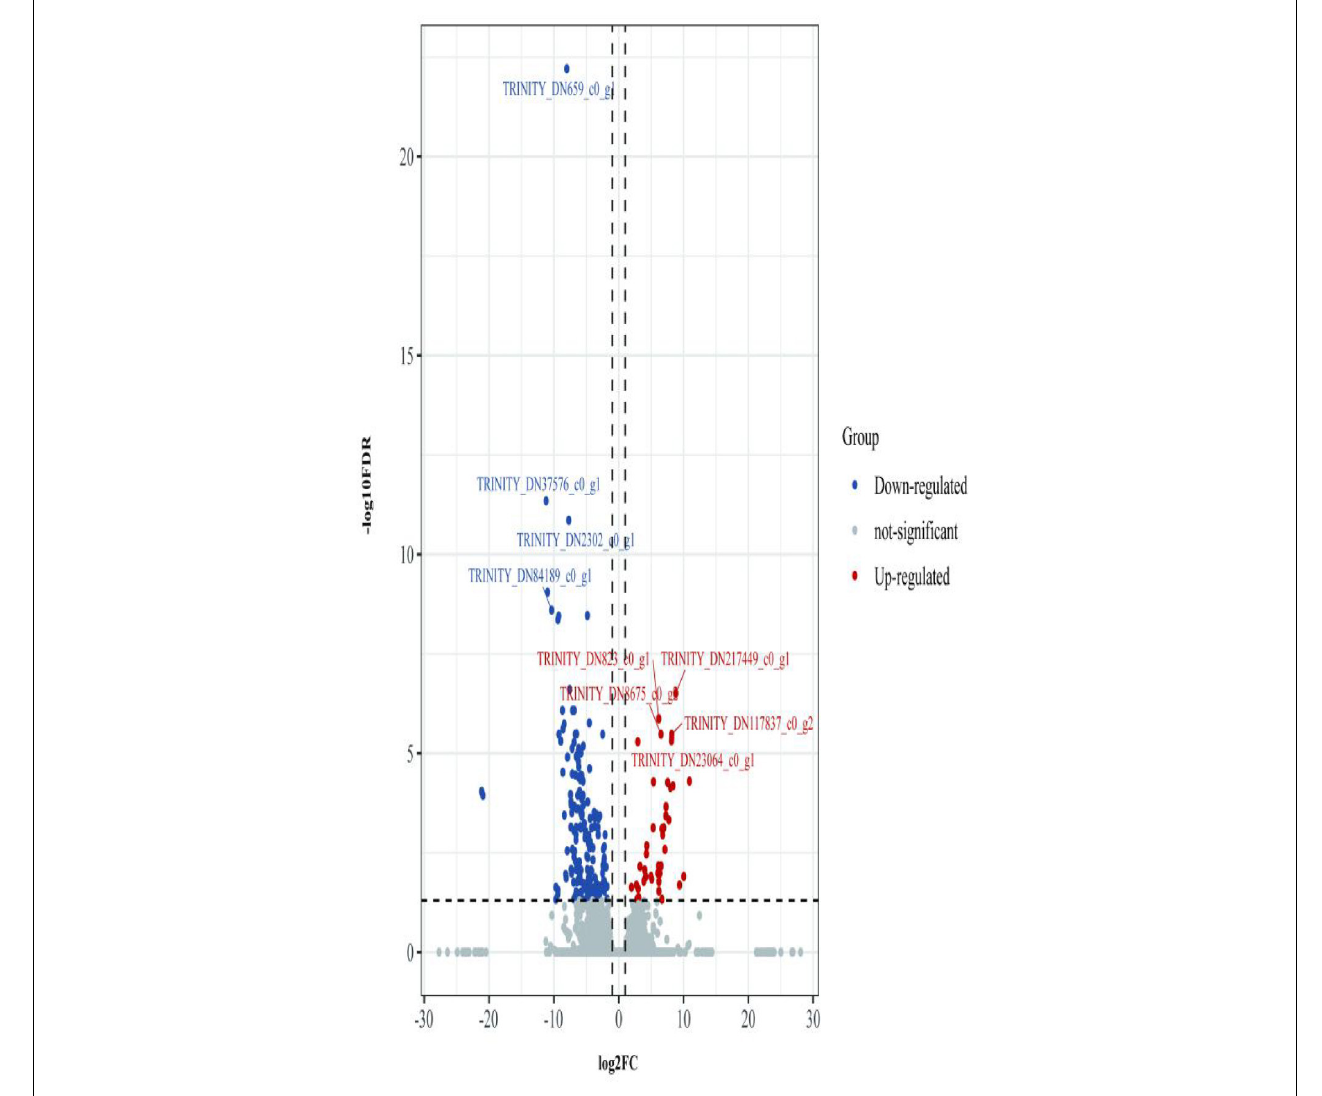
FIGURE 6 | Volcano plot obtained from the DESeq2 analysis of Epinephelus coioides ’s spleen RNA pools (5 dpi).